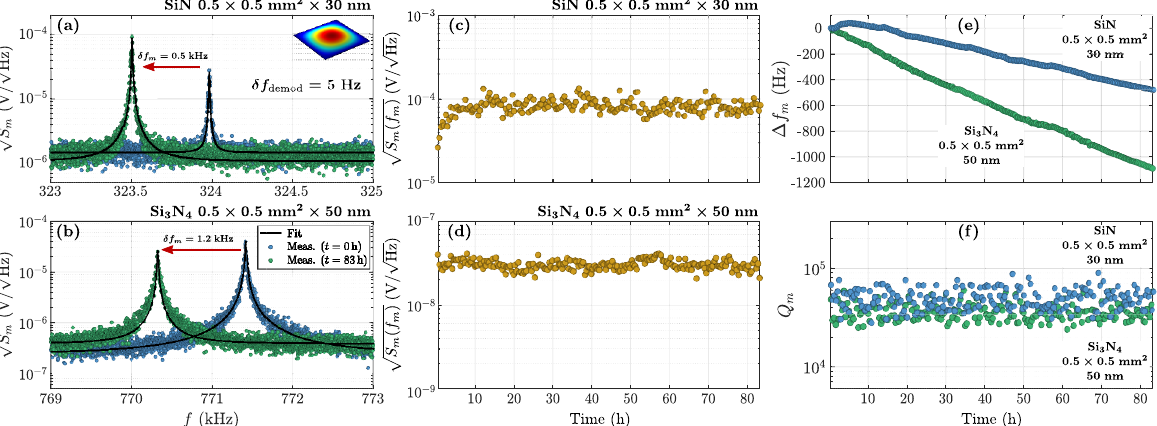
Figure 6. Long-term stability of the optomechanical signal. Two acquisitions of the optical PSD in V / √ Hz of: 0.5mm 2 30 nm ), and ( b ) a Si 3 N 4 membrane ( 0.5 0.5mm 2 50 nm ), nearby ( a ) a SiN membrane ( 0.5 × × × × the fundamental resonance frequency, at different times of the same PDH stabilization closed loop. The black curves are the thermomechanical fits. ( c , d ) Extracted optomechanical signal at mechanical resonance for, respectively, the SiN and the Si 3 N 4 membranes, as a function of the time. ( e ) Extracted resonance frequency shift (cid:31) f m and ( f ) mechanical quality factor Q m for both mebranes, as a function of the